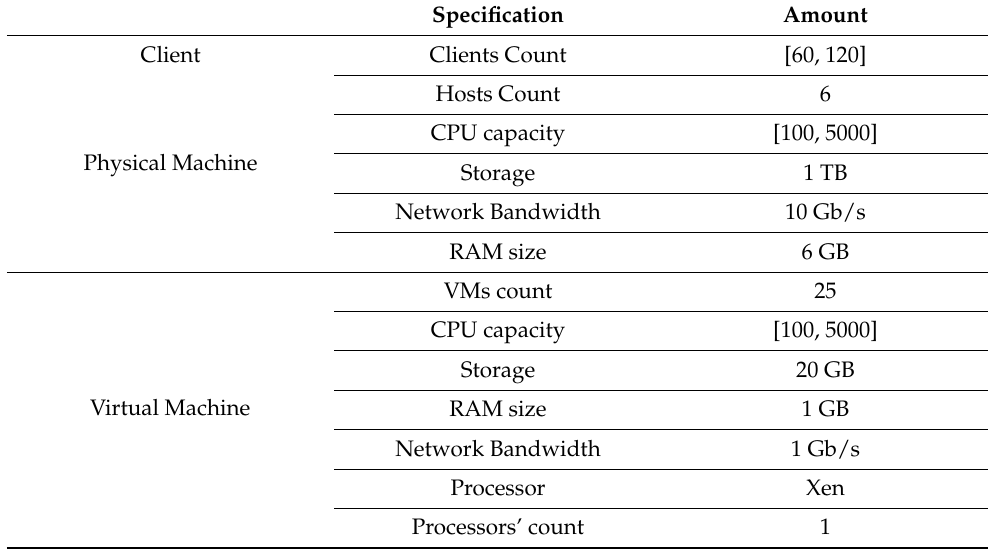
Table 1. Experiment parameters.